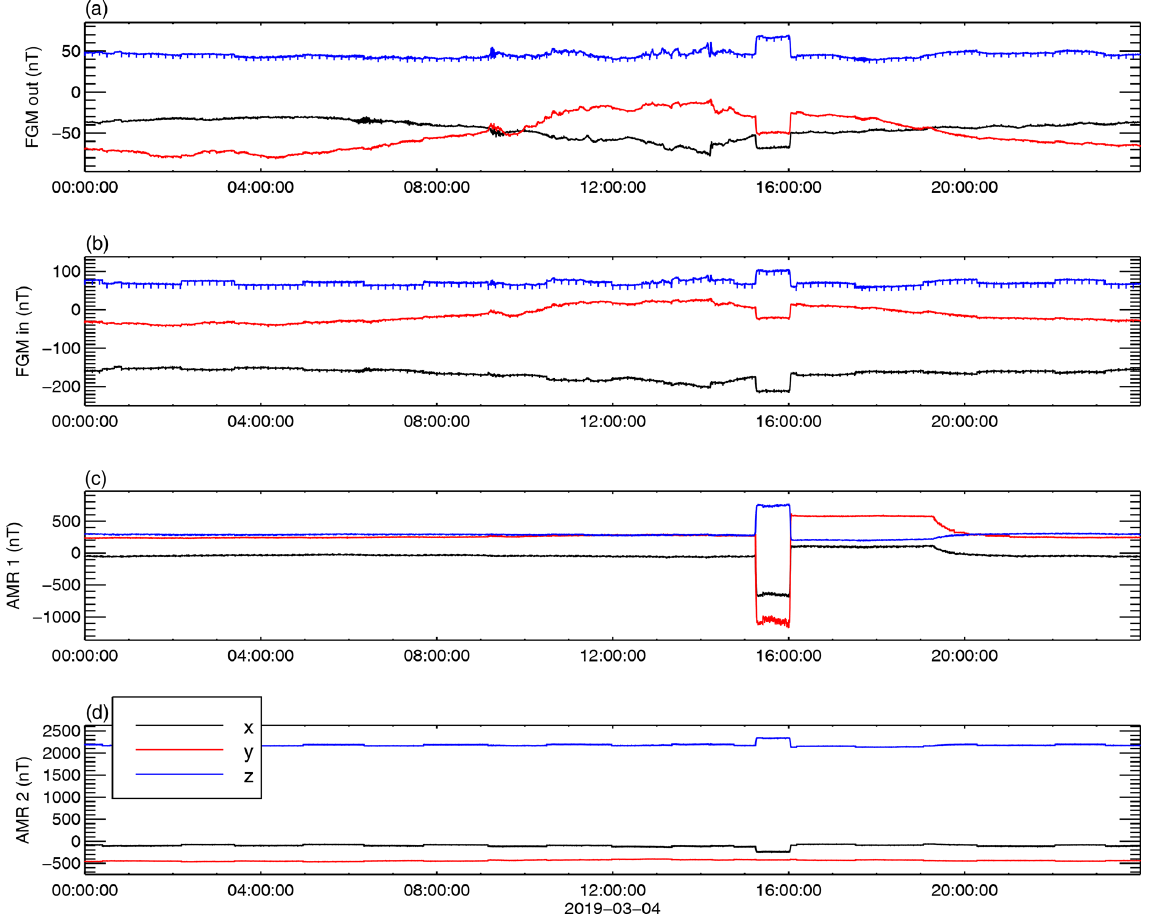
Figure 1. The components in the OB sensor system of the uncorrected measurements taken by the four magnetometers onboard GK2A on 4 March 2019. (a–b) FGMO, FGMI, AMR1, and